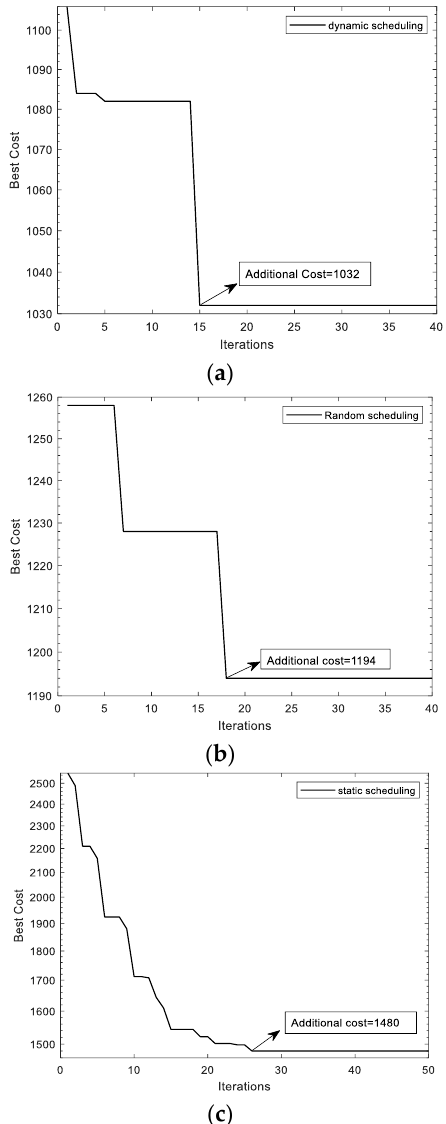
Figure 5. ( a ) Dynamic scheduling. ( b ) Random scheduling. ( c ) Static scheduling.